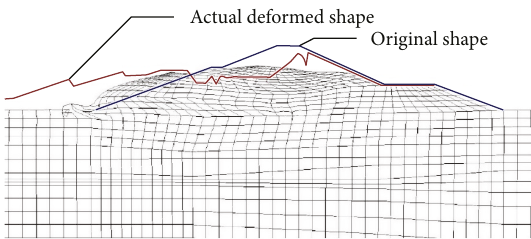
Figure 15: Comparison between deformed mesh, original embankment shape, and actual deformed shape.